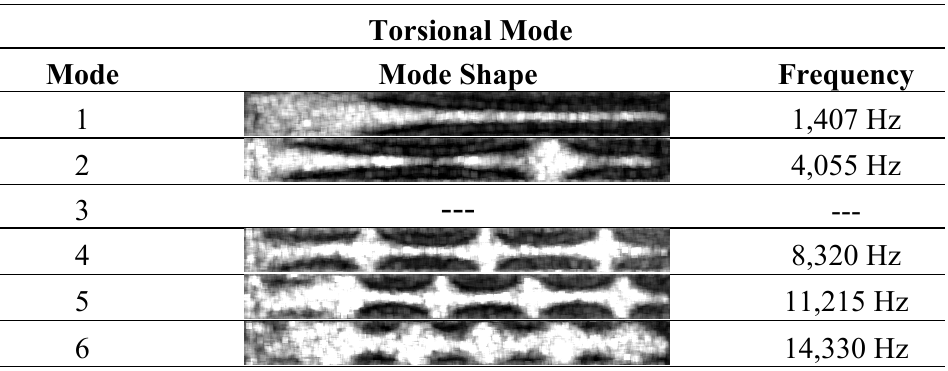
Table 3. Torsional modes of the smart cantilever beam.